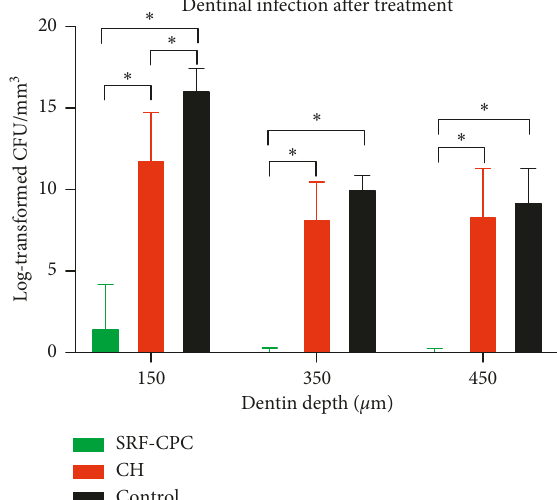
Figure 2: SRF-CPC’s efficacy against E. faecalis inside dentinal tubes at different dentin depths. Equation Y transformation. Data are expressed as mean